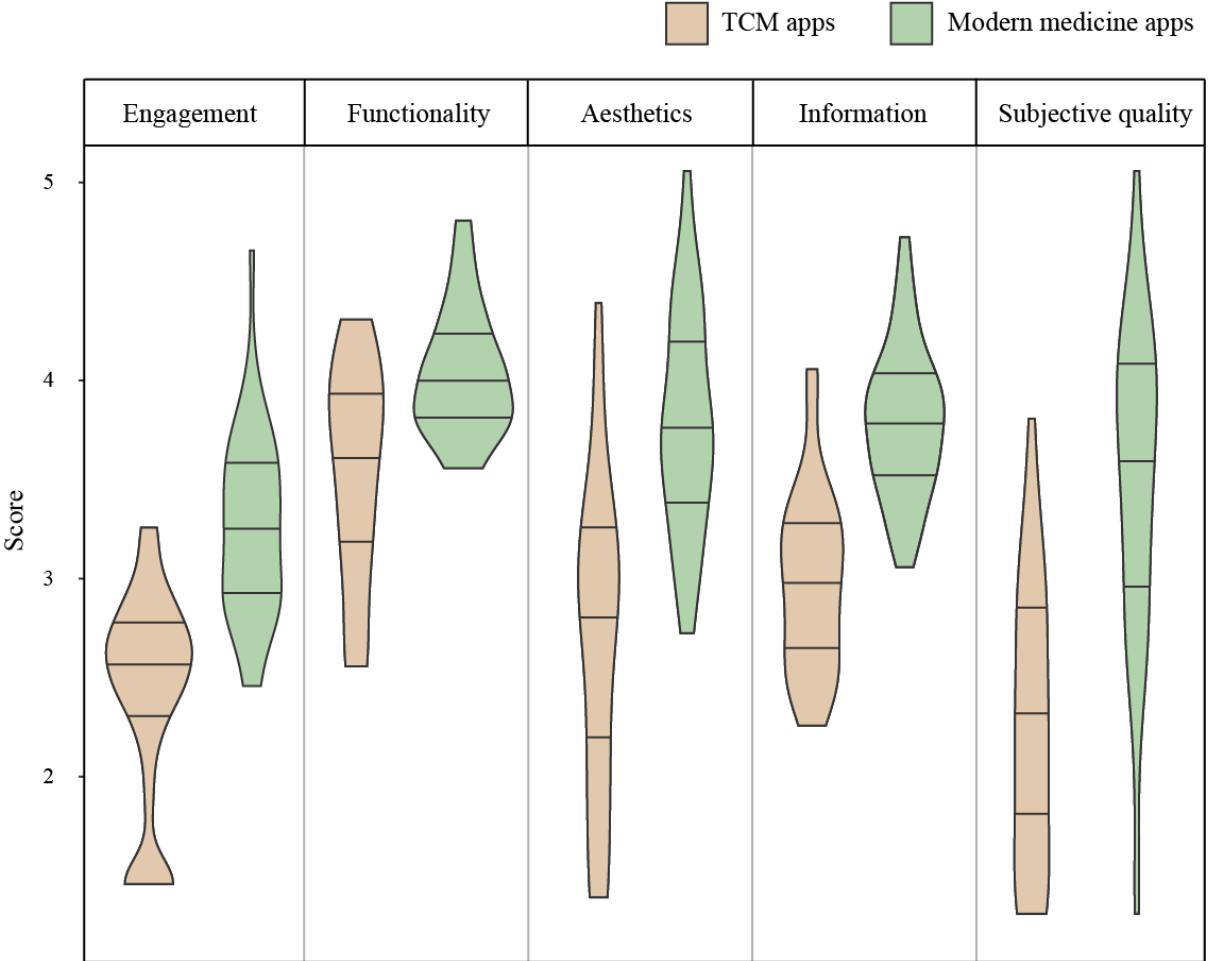
Figure 5. Violin plot of the Mobile Application Rating Scale section item scores. The 3 black lines in each plot present the first quartile, the median, and the third quartile (from bottom to top). TCM: traditional Chinese